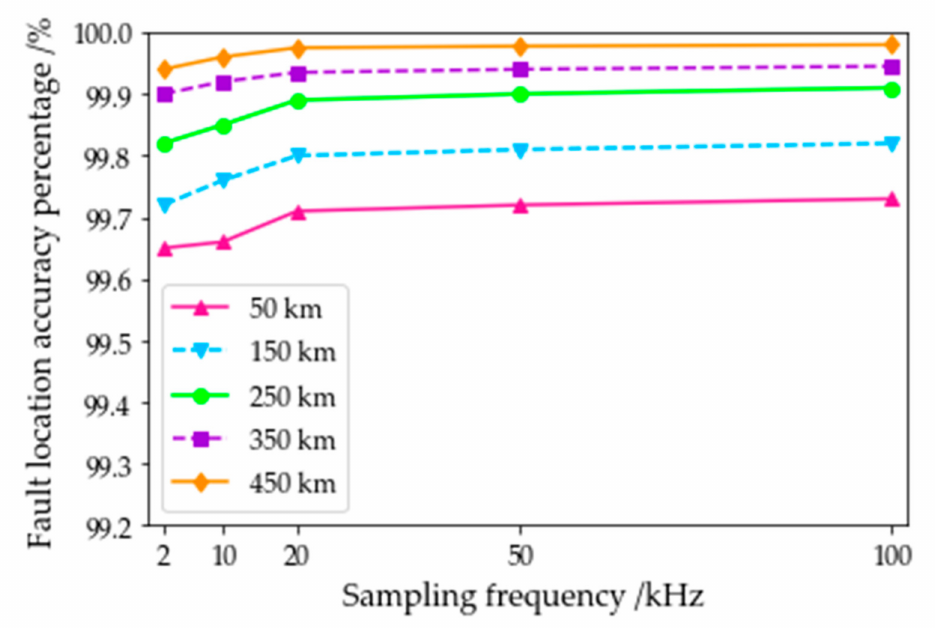
Figure 19. Test results at different sampling